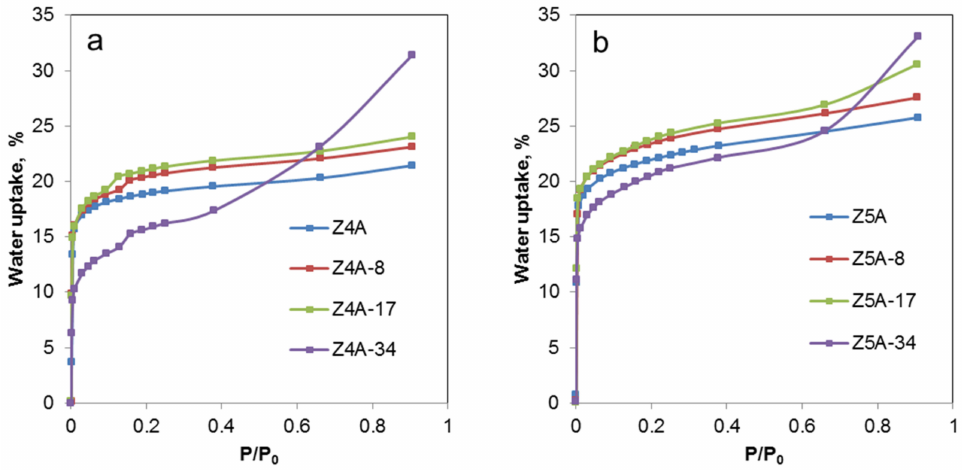
Figure 6. Water adsorption isotherms of parent and EDTA dealuminated zeolite 4A ( a ) and 5A samples ( b ).